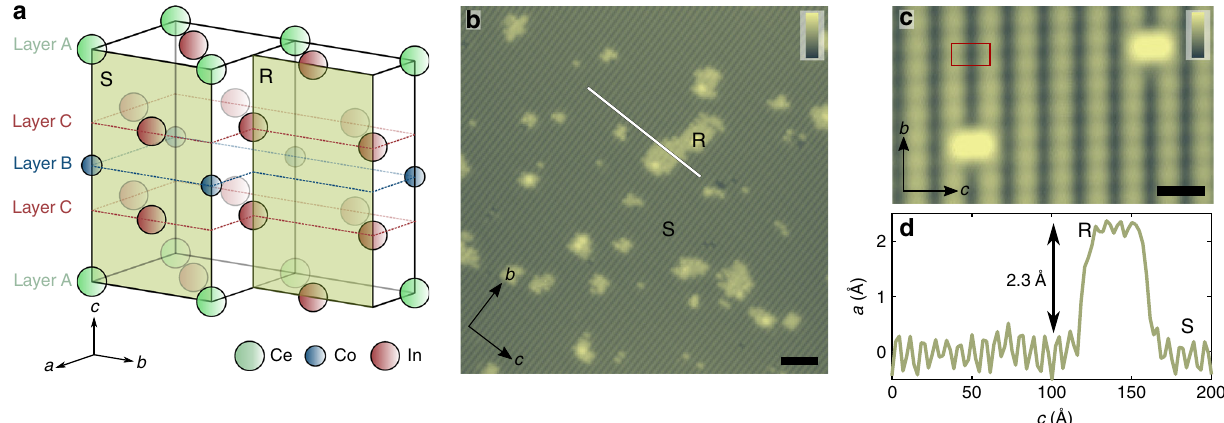
Fig. 1 STM topographic images of the [100] surface of CeCoIn 5 . a Schematic diagram of the bulk crystal structure of CeCoIn 5 showing the two possible surface terminations (S and R) when cleaving along the [100] orientation. Lines indicate the positions of layers A, B, and C. The lattice constants are a = b = 4.6 Å and c = 7.52 Å. b Constant current topographic image ( V = − 100 mV, I = 1.2 nA) of the [100] surface, which displays a large atomically bias setpoint ordered surface S and small islands of the reconstructed surface R. Scale bar: 50 Å; color scale: 7 Å. c Topographic image of a few unit cell area on surface S with red rectangular showing a unit cell on the b – c plane. Scale bar: 10 Å; color scale: 2 Å. d Topographic linecut along the white line indicated on b , which shows the height difference between surface S and R and corresponds to a /2 = 2.3